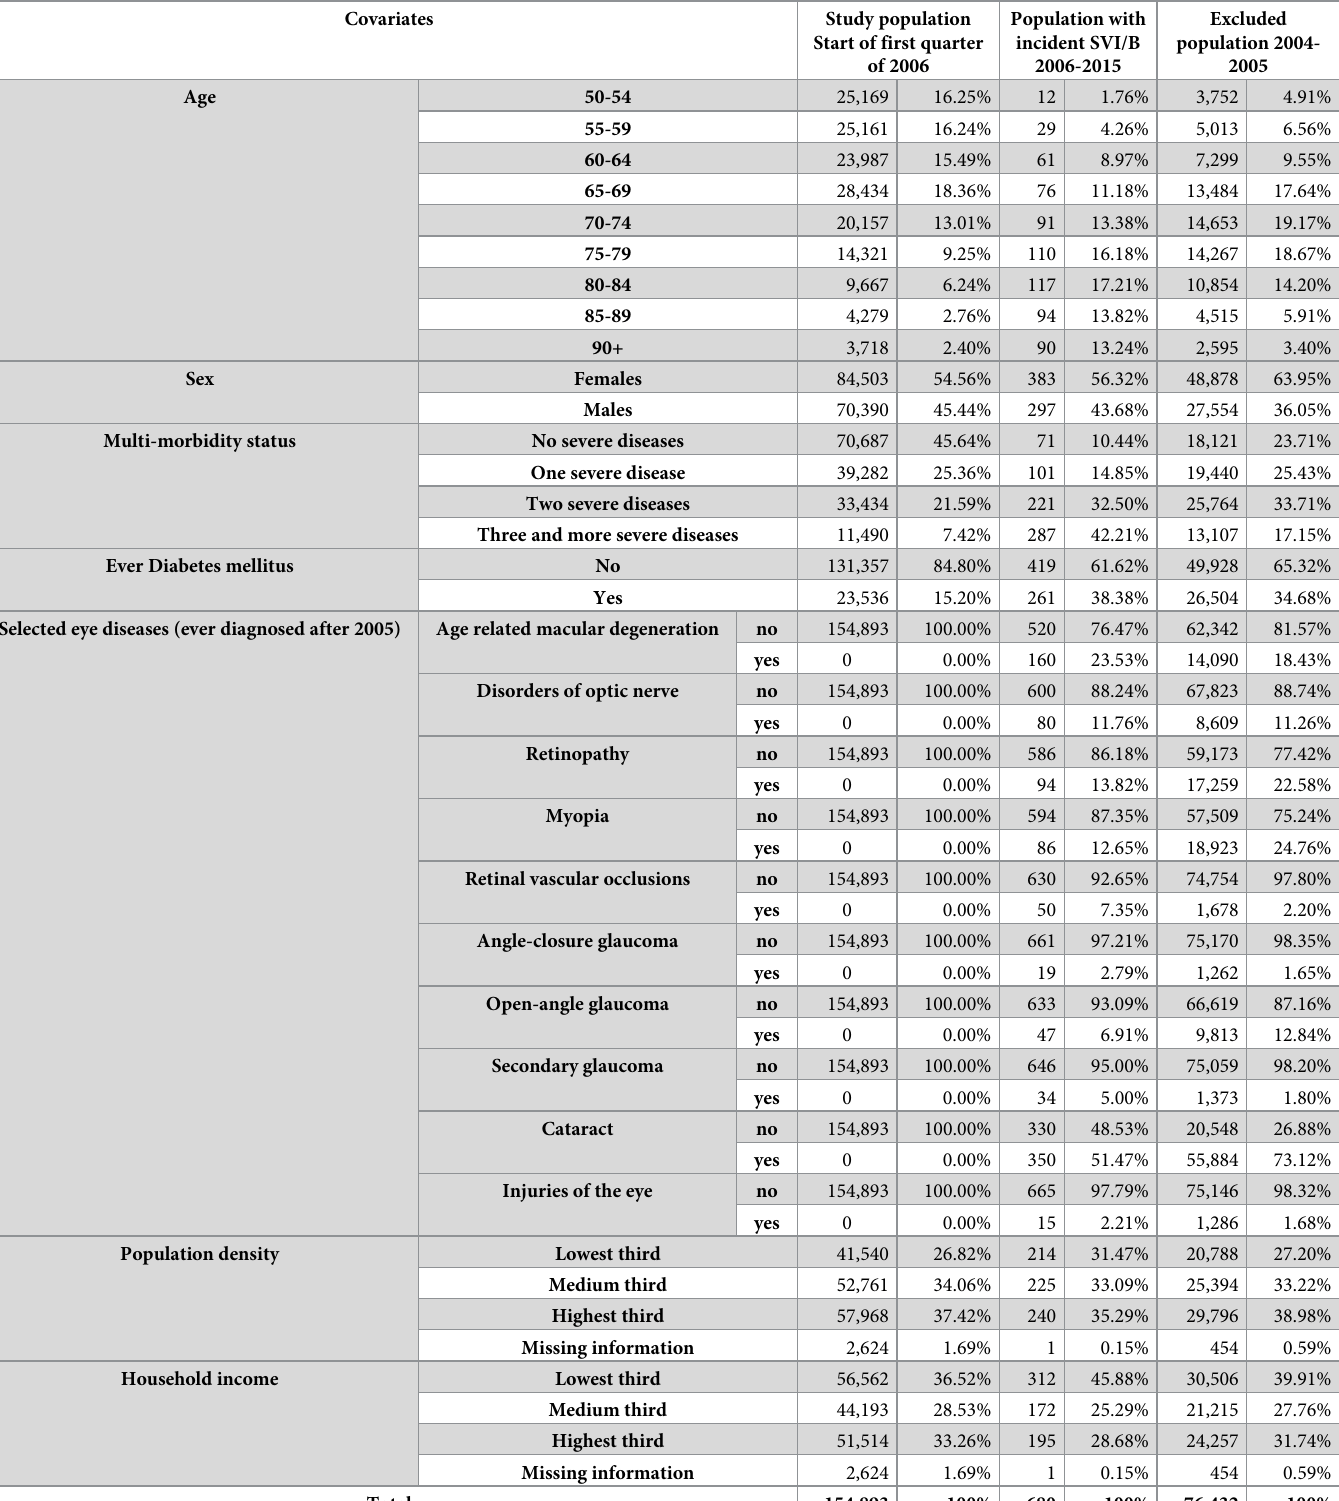
Table 2. Characteristics of the study population of Sample II, the population with incident SVI/B, and the excluded population, 2004-2015, AOK data. Covariates